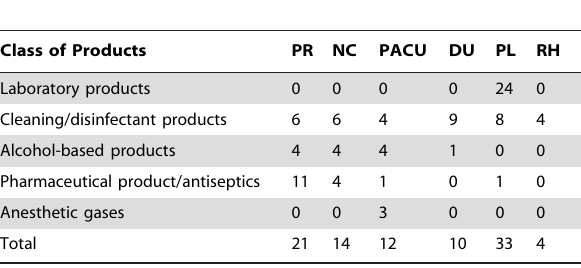
Table 3. List and number of different class of products used in the six sampling